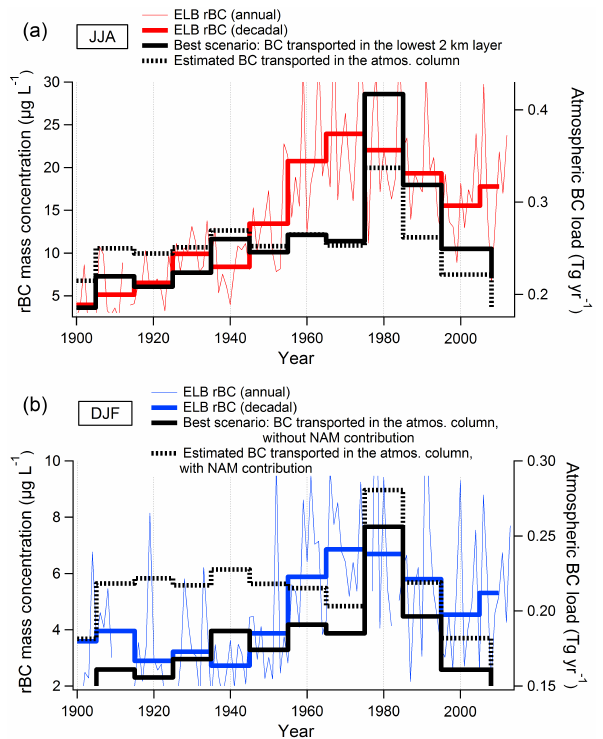
Figure 9. Comparison in temporal evolution between the rBC mass concentration of the ELB ice core and the estimates of atmospheric BC load at the ELB site, on a decadal scale. (a) JJA and (b) DJF. Best scenarios for atmospheric BC load are shown in black thick lines. In (b) , NAM stands for North